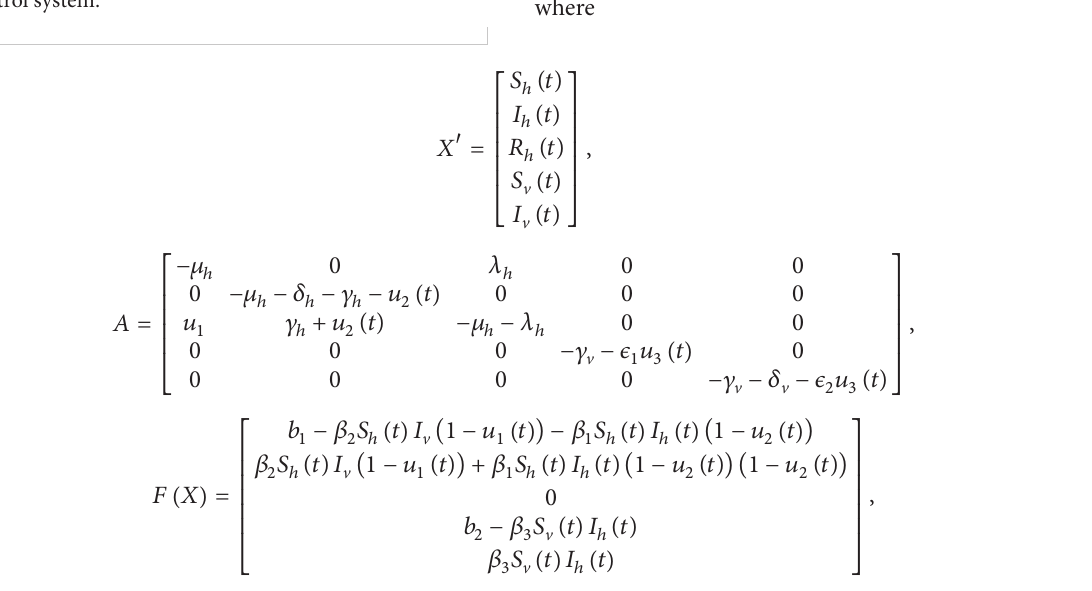
Figure 1: The plot shows the backward bifurcation for control and without control